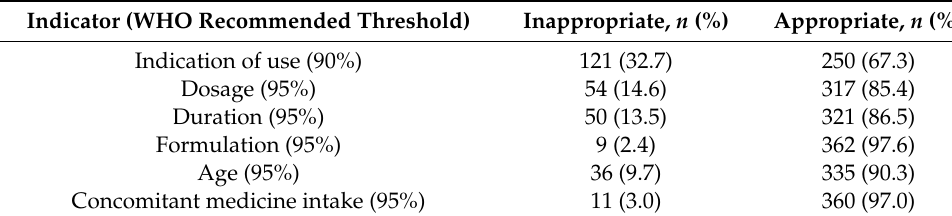
Table 3. Distribution of the reasons for inappropriate use of levofloxacin in 371 studied prescriptions (100%) according to the British National Formulary and also WHO recommended indicators and thresholds (see Methods).